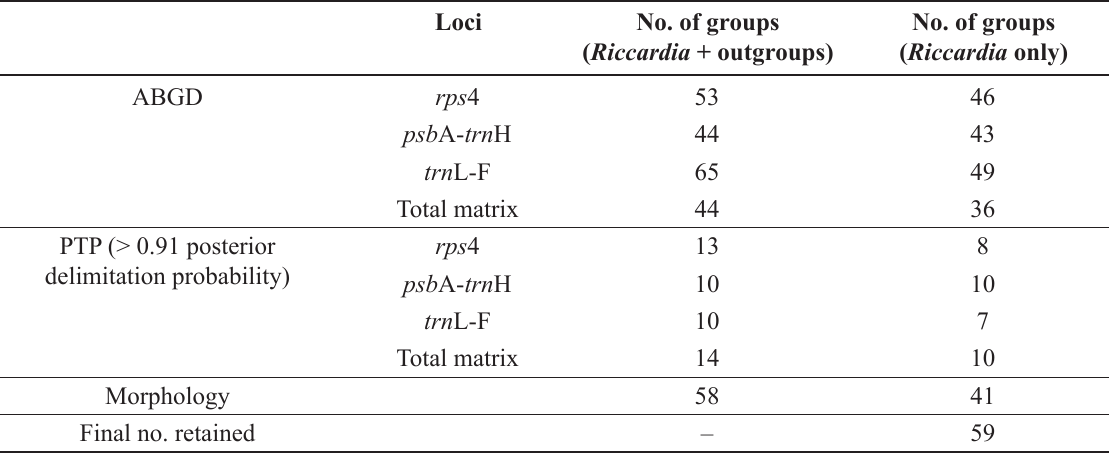
Table 4. Comparison of results given by three different methods of species delimitation used for our study in terms of number of species hypotheses: ABGD, PTP and morphological